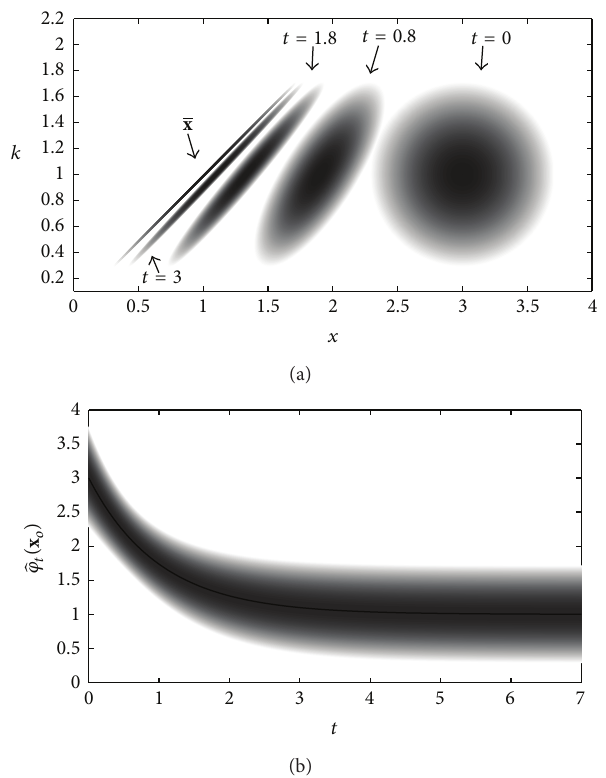
Figure 6: (a) Evolution of ̂𝜓 𝑡 ( y 𝑜 ) . (b) Evolution of fuzzy projection of ̂𝜑 𝑡 ( y 𝑜 )